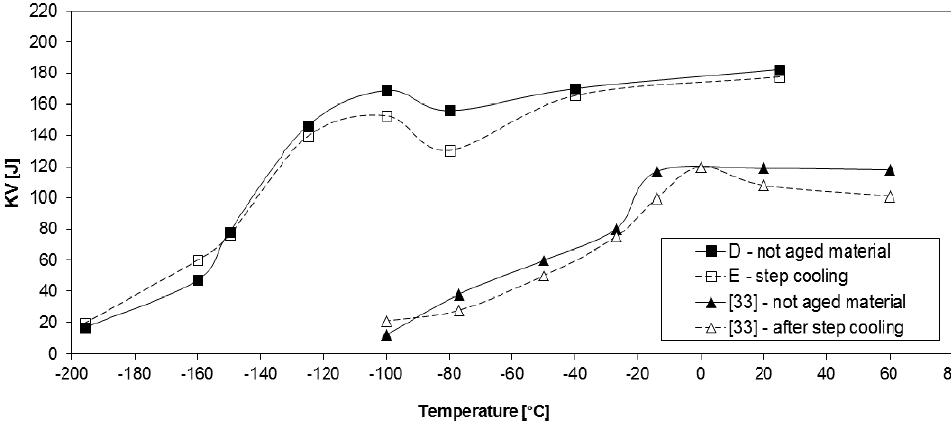
Figure 3. Impact test ductile ‐ to ‐ brittle transition curves for not aged and after step